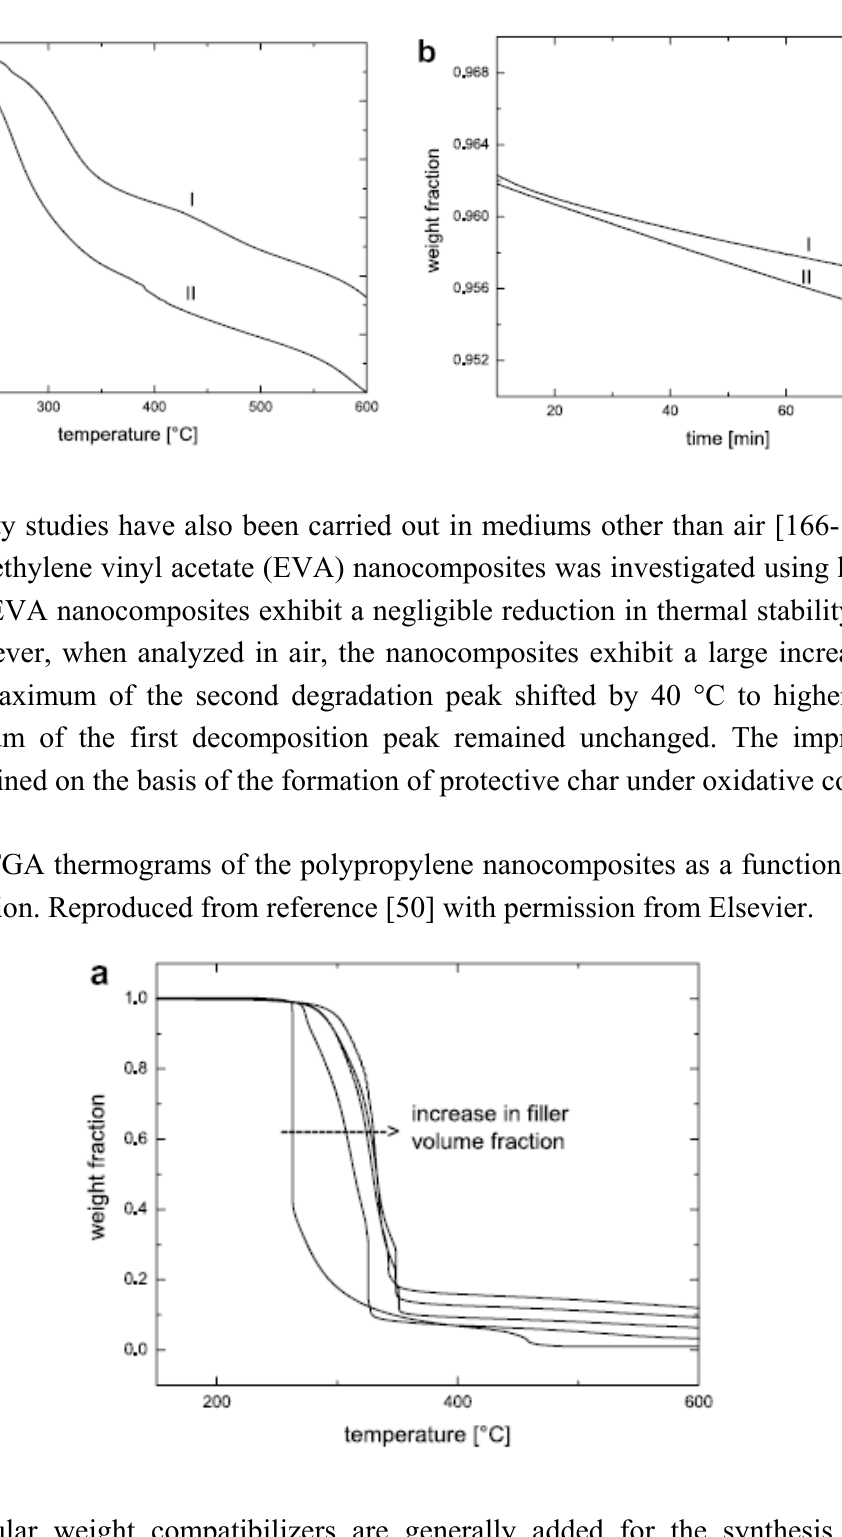
Figure 43. (a) TGA thermograms of the montmorillonite modified with 1-decyl-2-methyl- 3-octadecylimidazolium (I) and dioctadecyldimethylammonium (II) and (b) dynamic thermogravimetric analysis of the modified montmorillonites. Reproduced from reference [50] with permission from Elsevier.